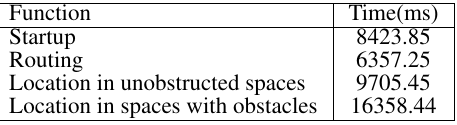
Table 5. Response times of the main functions of the